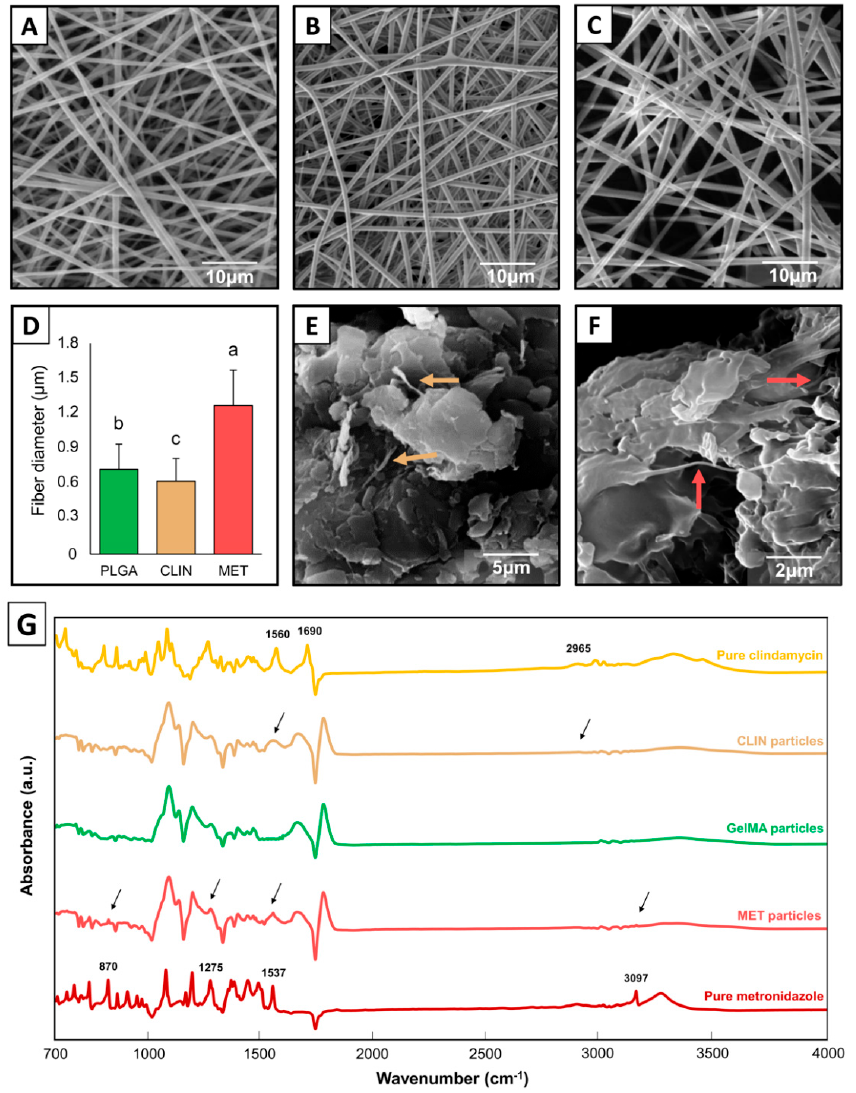
Figure 1. Representative SEM micrographs of electrospun and cryomilled fibers. ( A ) PLGA fibers (control); ( B ) CLIN-laden fibers; ( C ) MET-laden fibers; ( D ) graph showing the average fiber diameter of the electrospun fibers, with different letters above standard deviation bars, indicating statistical differences among the groups ( p < 0.05); ( E ) fiber-based particles comprised of CLIN, yellow arrows indicate CLIN-laden fibers, and ( F ) fiber-based particles comprised of MET, red arrows indicate MET-laden fibers; and ( G ) FTIR spectra of pristine antibiotics (CLIN and MET) and GelMA particles, as well as the processed antibiotic-modified GelMA particles, black arrows indicate characteristics peaks of each antibiotic. SEM, Scanning Electron Microscope; PLGA, Poly(lactic-co-glycolic acid); CLIN, Clindamycin; MET, metronidazole; FTIR, Fourier-transform infrared spectroscopy; GelMA, gelatin methacryloyl